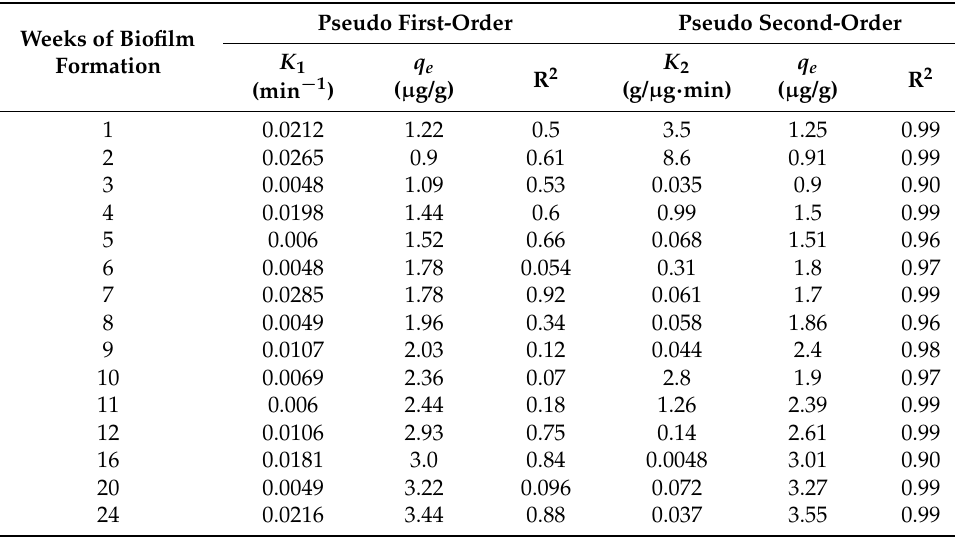
Table 7. Kinetic parameters for adsorption of CBZ onto tezontle with